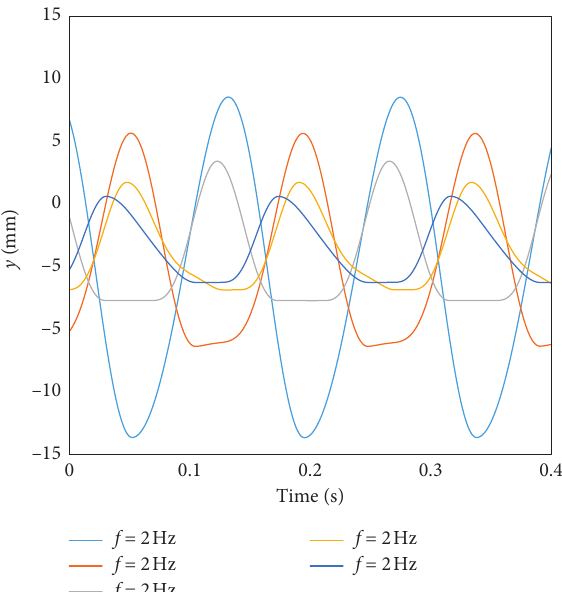
Figure 14: The influence of bolster stiffness on the response of the suspension system when excitation amplitude � 15mm and frequency � 7Hz.